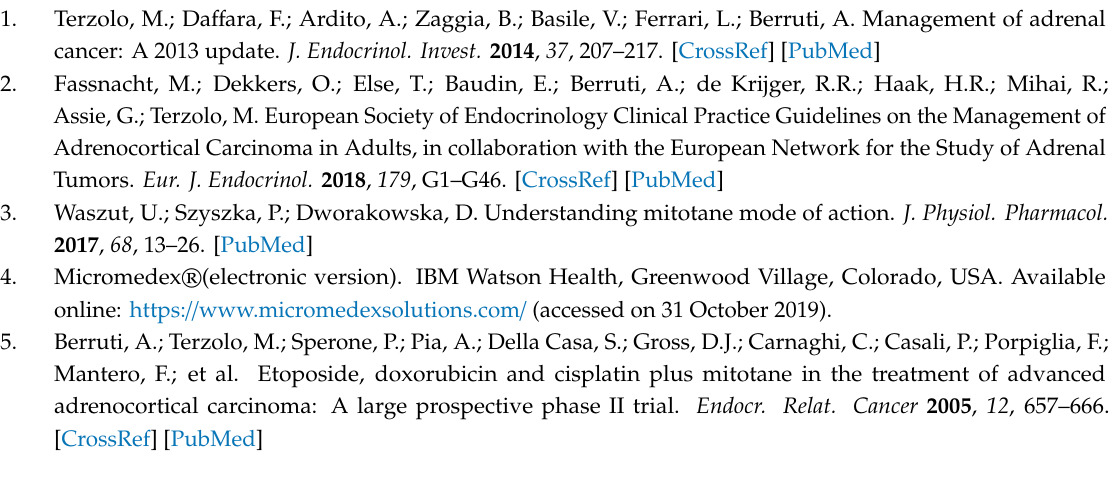
Figure S1 E ff ect of trabectedin on DNA integrity, Figure S2 Trabectedin promoted apoptotic cell death in NCI-H295R cells, Figure S3 Cytotoxic e ff ect of trabectedin on SW13 cell line, Figure S4: Whole western blots of Figure 4, Figure S5 Representative figure of subfractions proteins of NCI-H295R. EN = Nuclear Extract, EC = Cytosolic Extract, Figure S6: Trabectedin exposure a ff ects the subcellular localization of β -catenin in NCIH295R